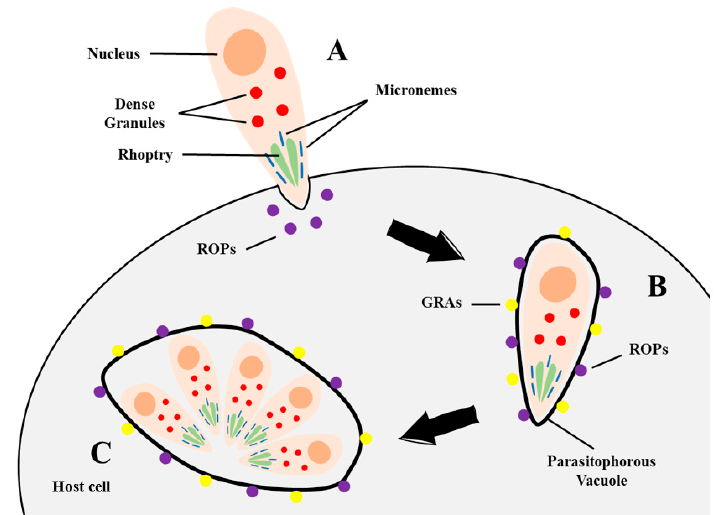
Figure 2. Toxoplasma gondii host-cell invasion and establishment of intracellular parasitic compart- ments [68–72]. ( A ) To invade the host cell, the parasite requires the secretion of proteins from two organelles, micronemes and rhoptries. These proteins allow the parasite to enter the host cell while coating itself with the host cytoplasmatic membrane, forming the Parasitophorous Vacuole